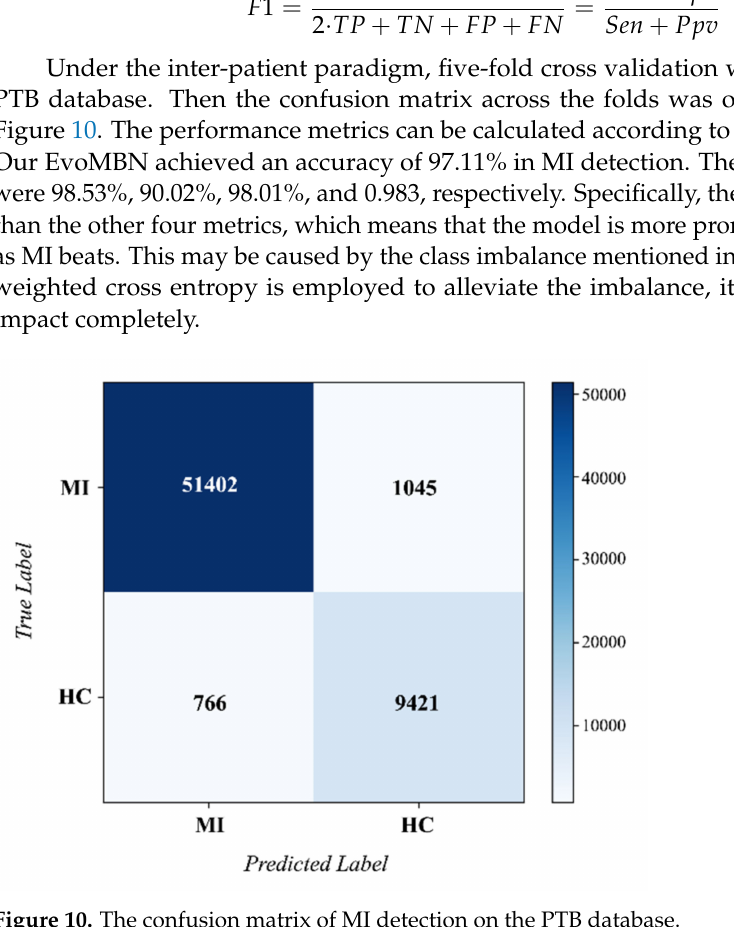
Figure 10. The confusion matrix of MI detection on the PTB